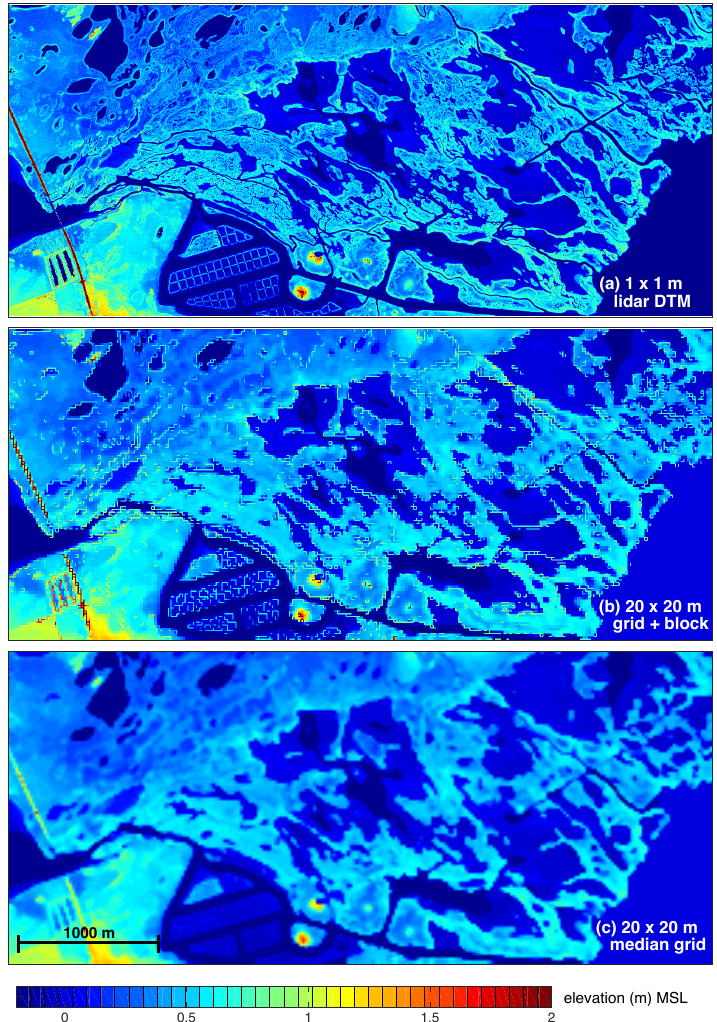
Figure 10. A section of the Nueces River delta (2.2km × 5km of a larger data set) centered at 27 ◦ 52 (cid:48) 25 (cid:48)(cid:48) N 97 ◦ 32 (cid:48) 21 (cid:48)(cid:48) W. Blocking faces at bridges and culverts have been manually removed. For clarity in (a) , where data are missing from the original lidar DTM (principally at water surfaces), the data have been replaced by − 0.2m. For the 20m × 20m grid, these data have been replaced by survey